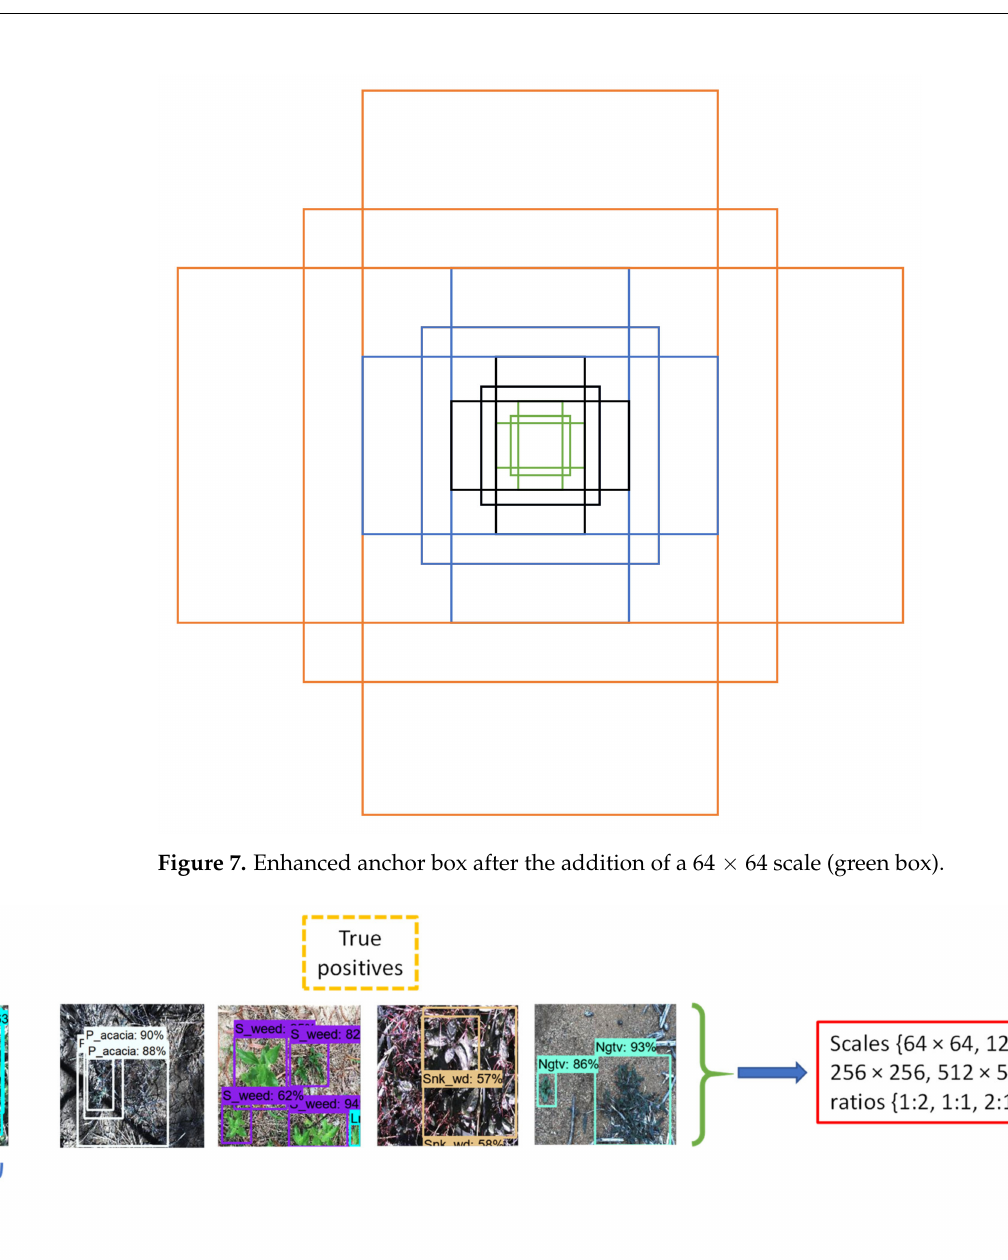
Figure 8. True positive results of Prickly acacia, Siam weed, Snakeweed, and negative class; False positive result of Chinee apple after the addition of a 64 × 64